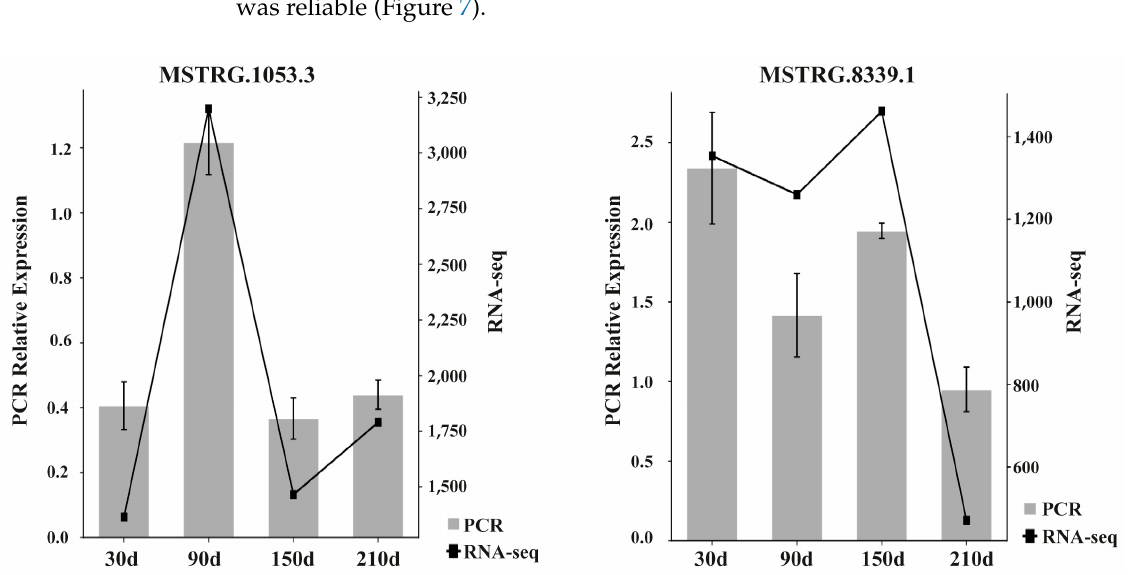
Figure 7. Transcription patterns of MSTRG.1053.3, MSTRG.11451.1, MSTRG.8339.1, MSTRG.10861.1, and MSTRG.1054.2 compared to expression patterns in the RNA-seq.